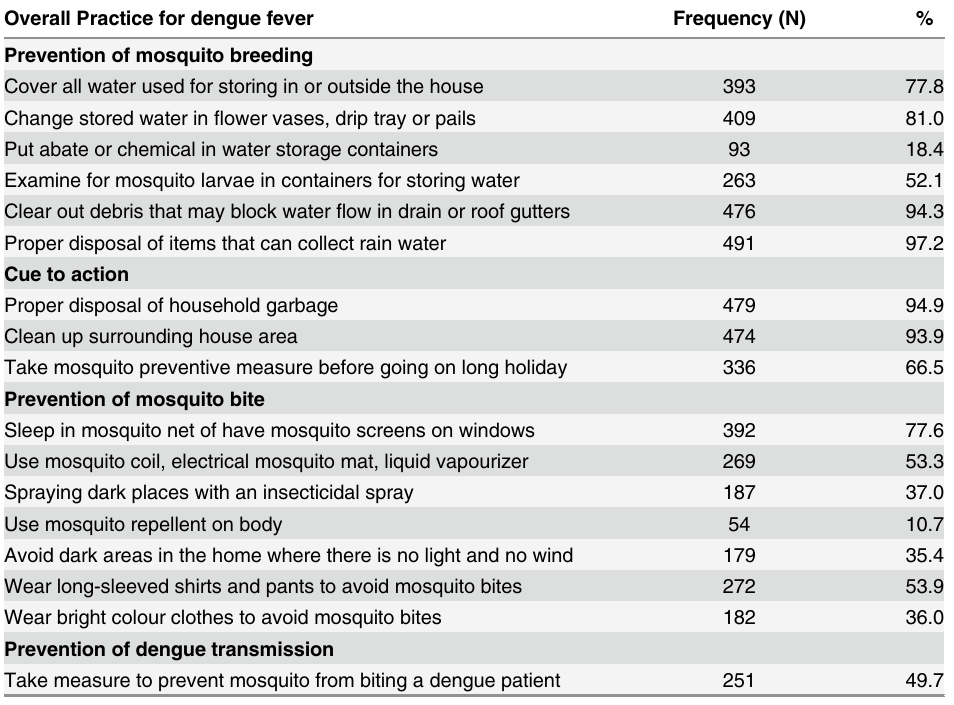
Table 3. Overall practices practiced by the Orang Asli to prevent dengue fever. Overall Practice for dengue fever Frequency (N) % Prevention of mosquito breeding Cover all water used for storing in or outside the house 393 77.8 Change stored water in fl ower vases, drip tray or pails 409 81.0 Put abate or chemical in water storage containers 93 18.4 Examine for mosquito larvae in containers for storing water 263 52.1 Clear out debris that may block water fl ow in drain or roof gutters 476 94.3 Proper disposal of items that can collect rain water 491 97.2 Cue to action Proper disposal of household garbage 479 94.9 Clean up surrounding house area 474 93.9 Take mosquito preventive measure before going on long holiday 336 66.5 Prevention of mosquito bite Sleep in mosquito net of have mosquito screens on windows 392 77.6 Use mosquito coil, electrical mosquito mat, liquid vapourizer 269 53.3 Spraying dark places with an insecticidal spray 187 37.0 Use mosquito repellent on body 54 10.7 Avoid dark areas in the home where there is no light and no wind 179 35.4 Wear long-sleeved shirts and pants to avoid mosquito bites 272 53.9 Wear bright colour clothes to avoid mosquito bites 182 36.0 Prevention of dengue transmission Take measure to prevent mosquito from biting a dengue patient 251 49.7